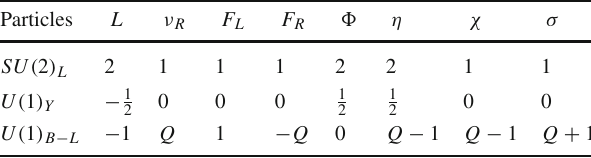
Table 1 Particle contents and corresponding charge assignment